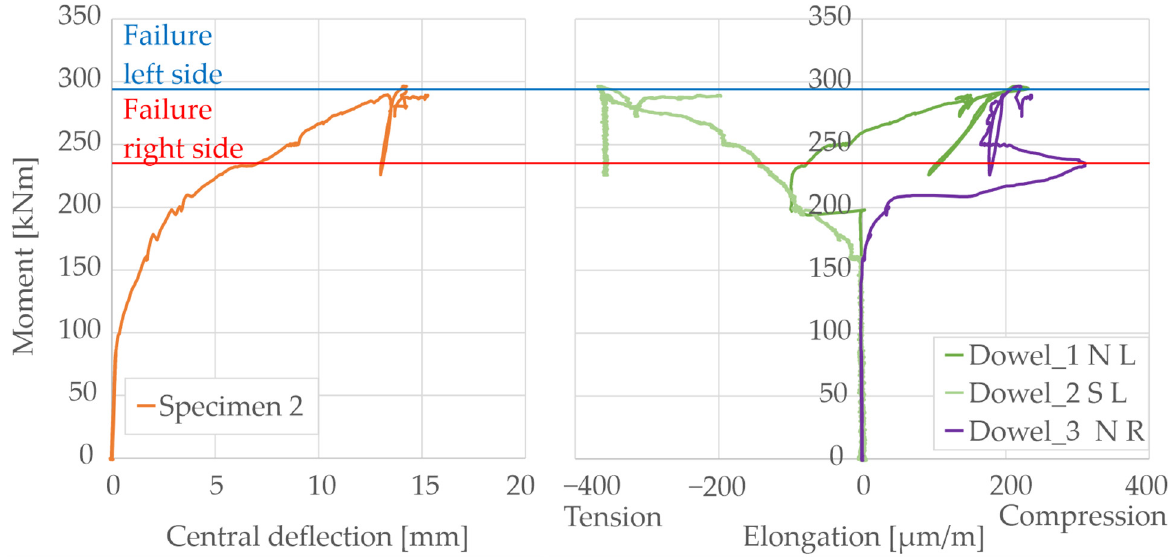
Figure 22. Measured dowel loads.